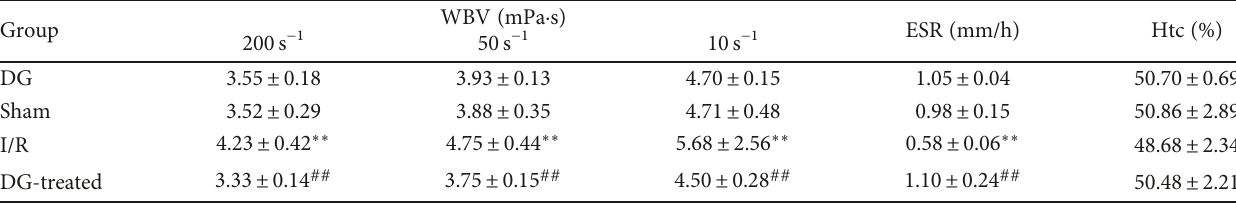
Table 3: E ff ect of Dunye Guanxinning on hemorheological parameters.